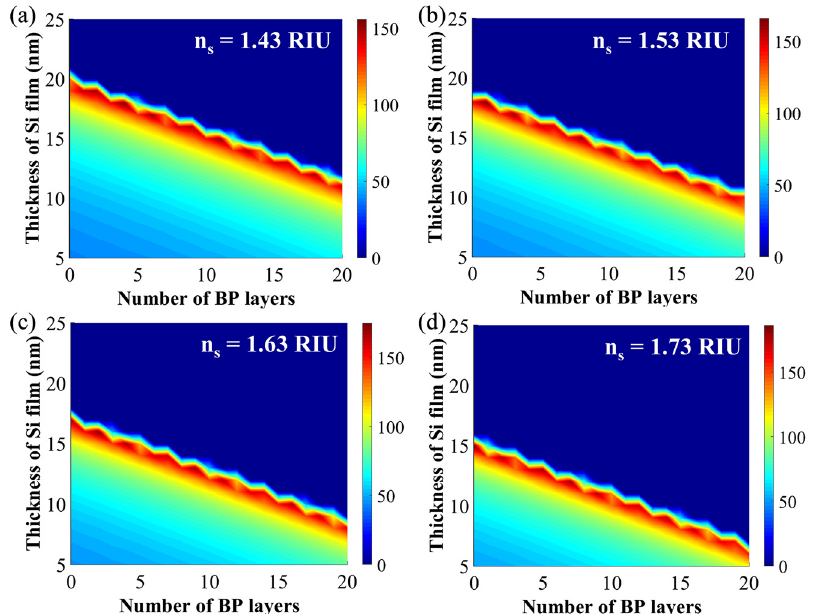
Figure 5c. Evidently, the graphene does not signi fi cantly affect the sensitivity enhancement. The primary functions of the graphene are to defend BP from oxidation and to act as a macromolecular trapping mechanism. Through optimizing the number of BP layers and the thickness of Si fi lm on sensitivity, we obtain an optimum sensitivity of 148.2 ° /RIU at L = 2 and d = 20 nm, as shown in Figure 5d. Si Thus, to further enhance the sensitivity, the number of BP layers and the thickness of Si fi lm must be simultaneously optimized. Furthermore, we discuss the combined effect of the number of BP layers and the thickness of Si fi lms when the sensing targets have different RIs, as shown in Figure 6. The results show that the sensitivities with a speci fi c RI can be optimized by adjusting the layer of BP and the thickness of Si fi lm, and the optimum sensitivities are 155.2 ° /RIU, 166 ° /RIU, 175.2 ° /RIU, 186.2 ° /RIU with the RI of 1.43 RIU, 1.53 RIU, 1.63 RIU, 1.73 RIU, respectively, which are shown in Table 2.